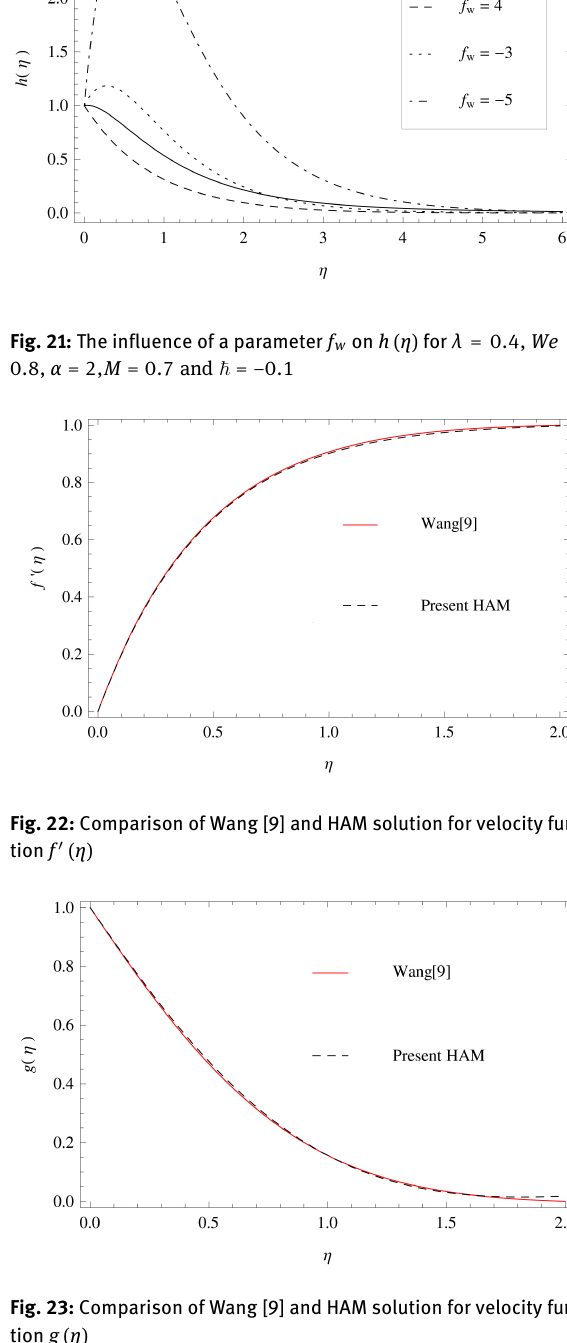
Fig. 20: The influence of a parameter M on h ( η ) for λ = 0.2, We = 0.6, α = 6, f = 0.1 and (cid:126) = −0.1 w